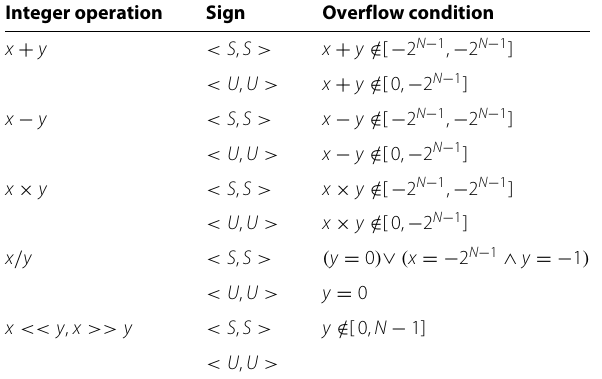
Table 3 Overflow condition for integer operations Integer operation